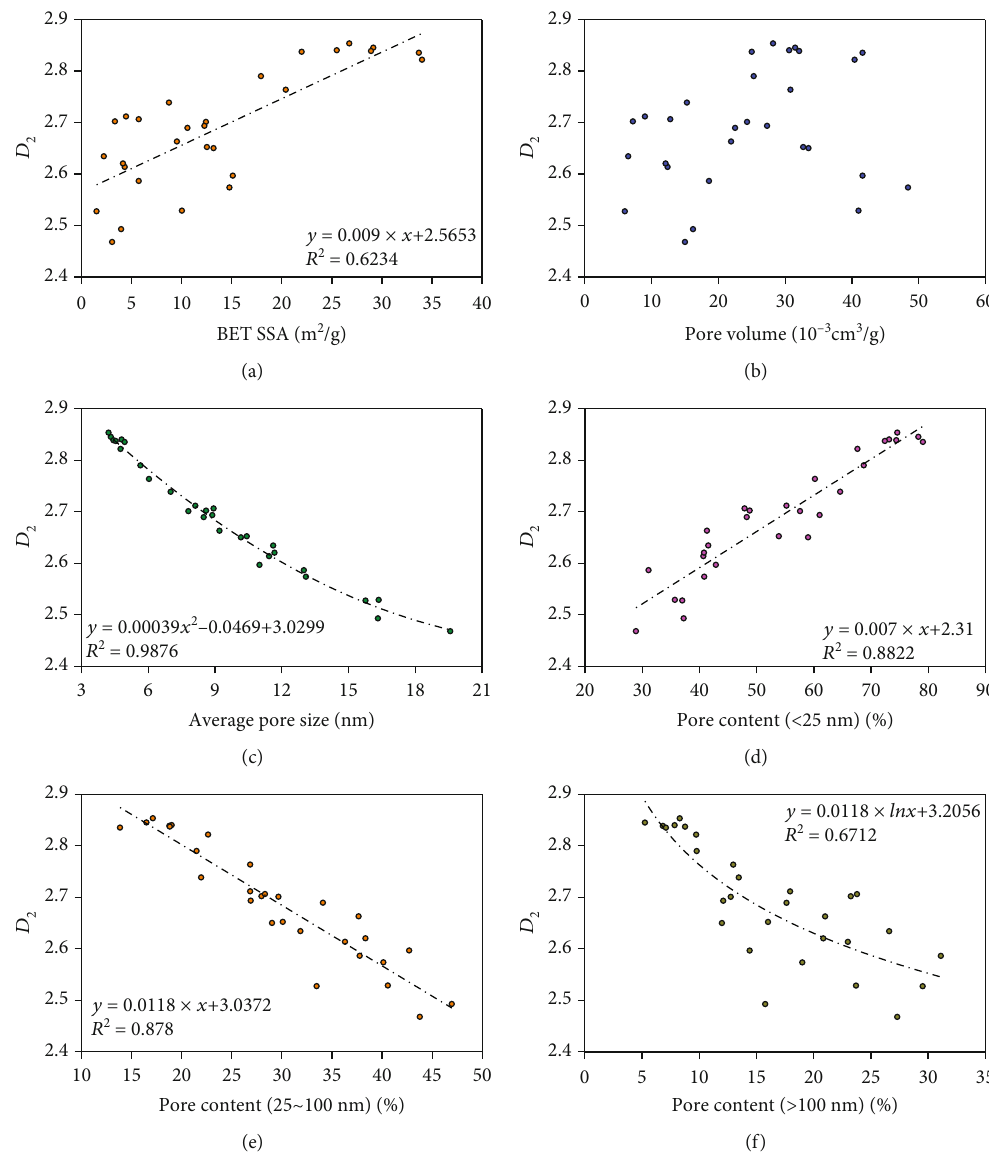
Figure 10: Relationships between D